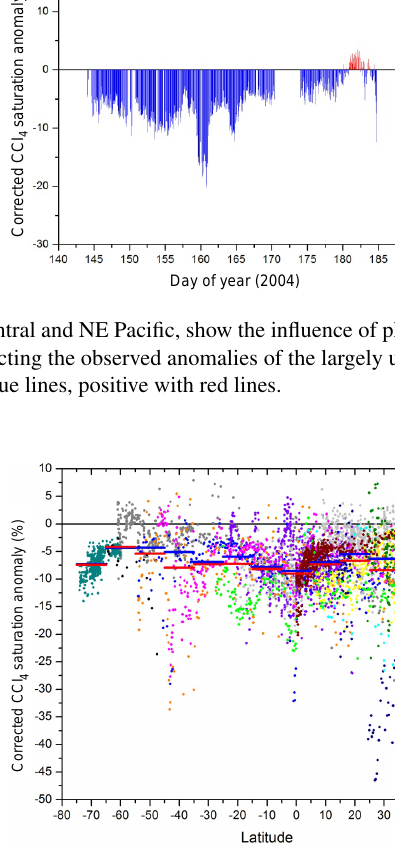
Figure 5. Zonal distribution of the corrected saturation anomaly from all cruises. Because observed positive values are likely the re- sult of contamination, external influences, or sampling or analytical artifacts, means and medians for each 10 ◦ latitudinal band (shown as the red and blue bars) are computed from negative saturations only (see